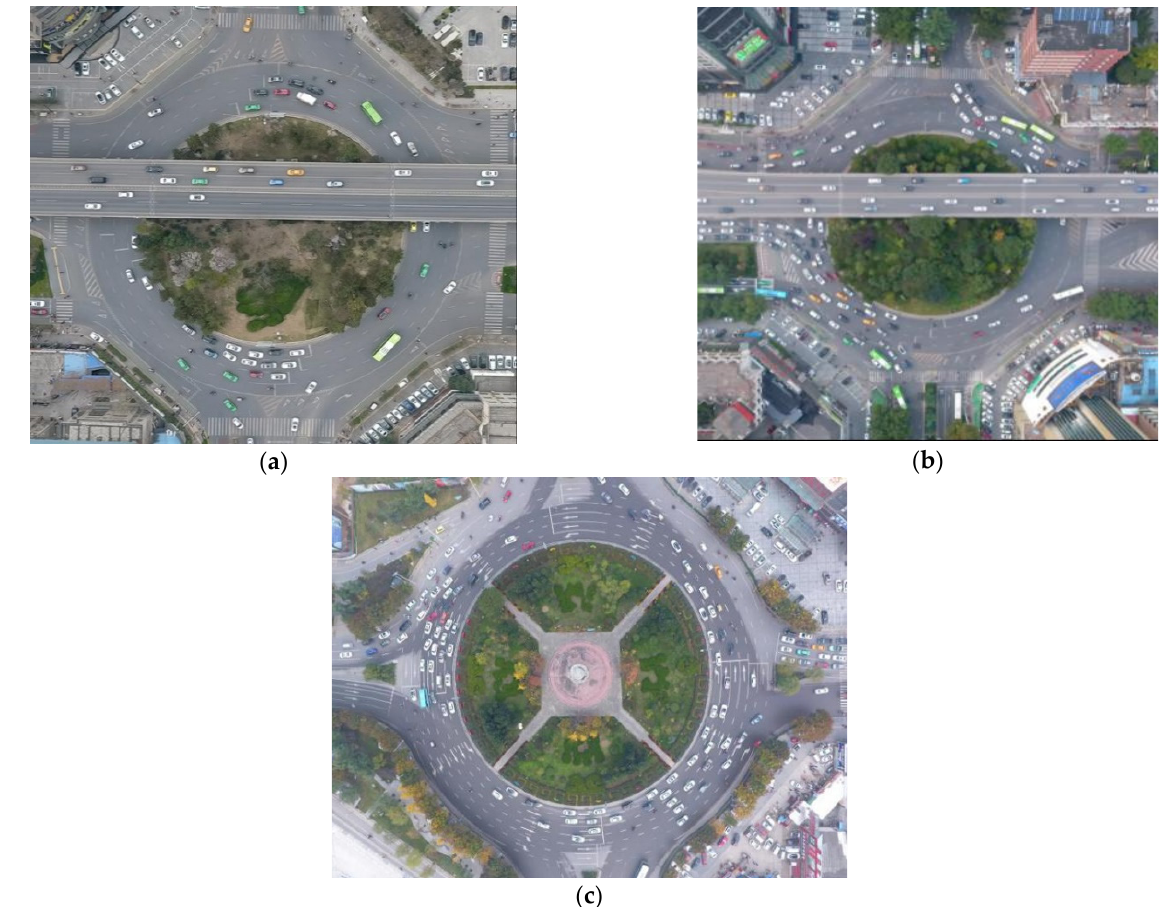
Figure 2. Aerial view of selected roundabouts. ( a ) Zhuque; ( b ) Hanguang; ( c ) Chenyangzhai. To determine the minimum sample size, pre-surveys during peak and flat hours were separately conducted from October 14 to 18, 2019. In total, 149 min of video data were collected. After data processing, the standard deviation of the conflicts per unit time (5 min) at the three roundabouts was 6.81. According to Equation (1), the minimum sam- ple size was figured out.